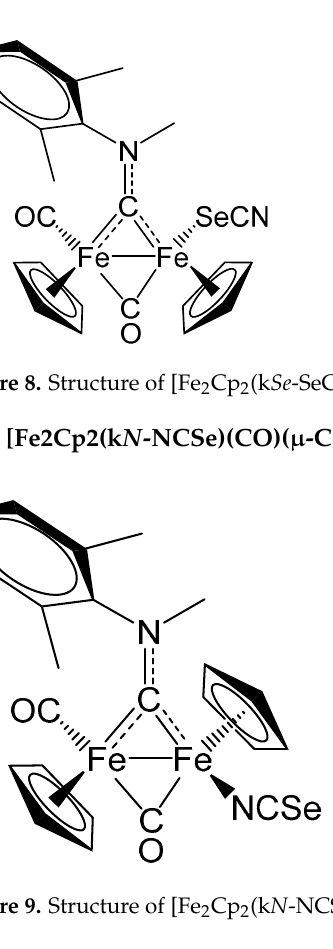
Figure 5. Structure of [Fe 2 Cp 2 (k N- NCO)(CO)(µ-CO){µ-CN(Me)(Me)}], 2b [39].